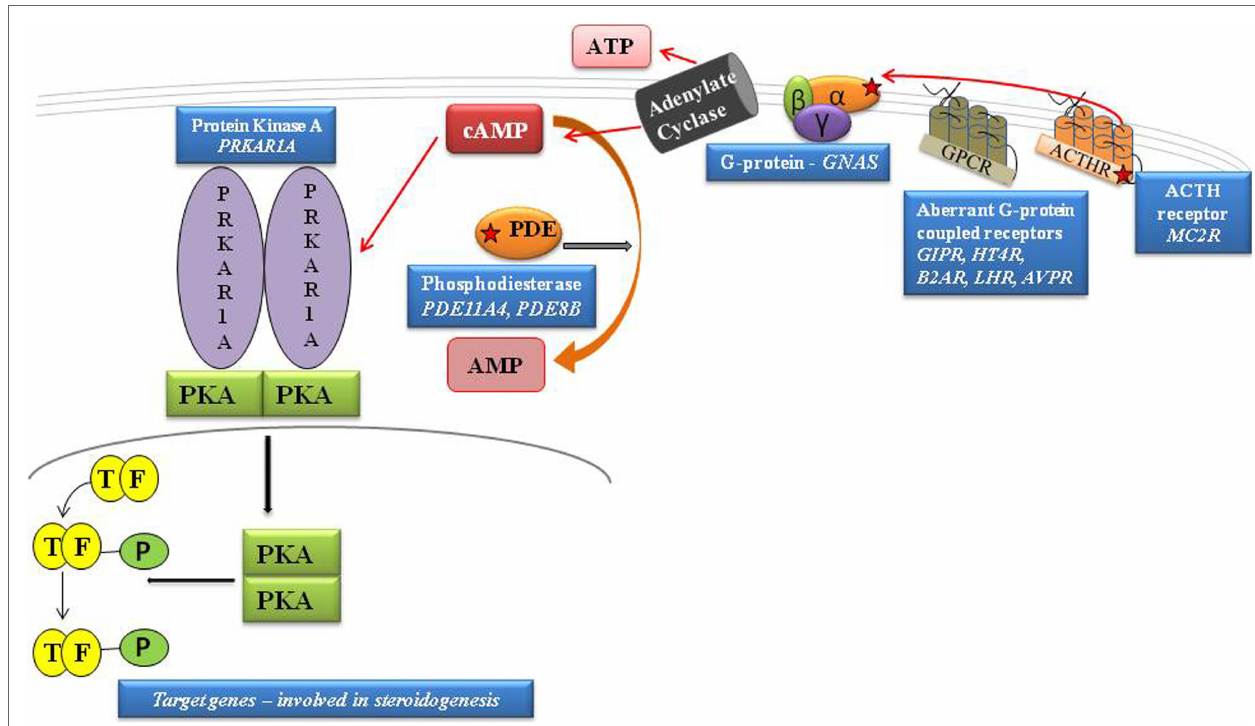
FiGURe 1 | Schematic representation of cAMP pathway . GPCRs cause the activation of G proteins by facilitating the exchange of GTP for GDP on the α subunit. cAMP is degraded to AMP by PDEs. PKA is activated by the rise in cAMP that, by binding both high-affinity cAMP-binding sites of each subunit, leads to the release of active subunits that phosphorylate their substrates, including the nuclear transcription factor, CREB. By inhibiting the intrinsic GTPase activity, gsp mutations cause constitutive activation of adenylyl cyclase (AC), leading to increased cAMP; protein kinase A activation. The protein kinase A (PKA) induces phosphorylation of the cAMP-binding protein, CREB, facilitating its traslocation to the nucleus and activation of cAMP-responsive gene transcription. [Adapted from Lacroix et al. ( 11)].